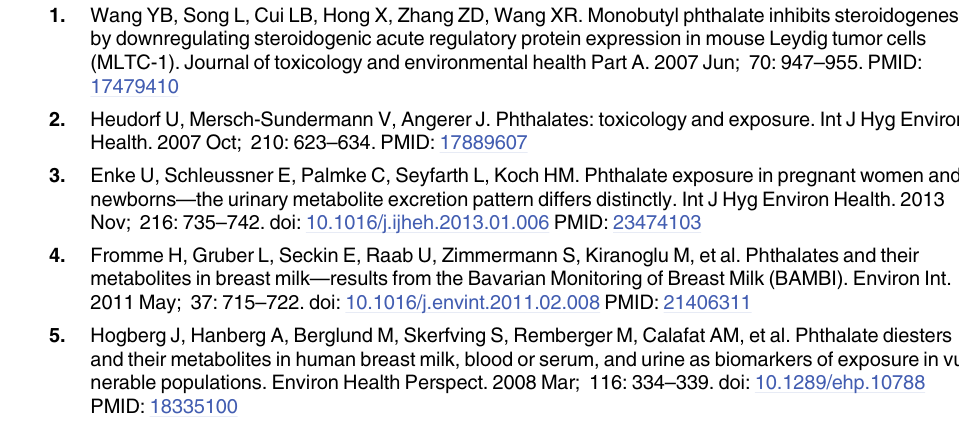
S1 Fig. Effects of MBP on the cell viability. The mouse (A) MLTC-1 and (B) Y1 cells were exposed to 0 ~ 106 nM MBP as indicated for 24 h, the cell viabilities were evaluated in triplicate by WST-8 hydrolysis using a Cell Counting Kit-8 assay. (cid:3) p < 0.05 compared with medium control cells. S2 Fig. Description of the vimentin promoter. (A) schematic illustration that the sequences “ CGGGCTTTCC ” in the vimentin promoter is similar to kappaB DNA elements (GGGRNYYYCC), and that these sequences were located in the CpG islands. (B) The pGL3-vi- mentin-Luc constructs (wild type, WT or mutated, MT). S3 Fig. Effects of NF- κ B on the expression of StAR. MLTC-1 cells were transfected by Con- siRNA or RelA-siRNA for 12 h. (A) Western blots analysis and (B)relative protein levels of